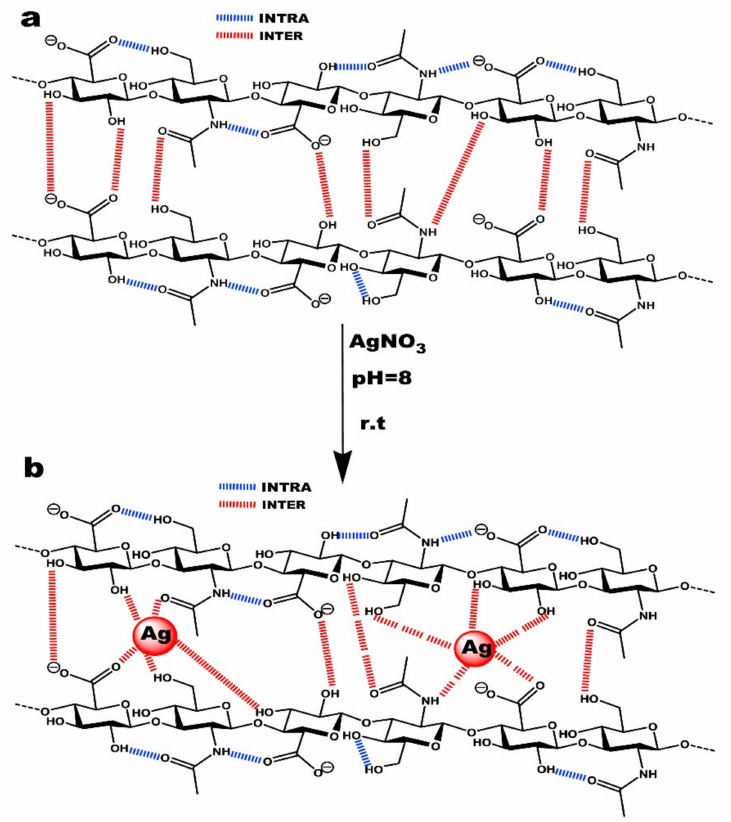
Figure 11. ( a ) Intra/intermolecular hydrogen bonds between hyaluronan chains and ( b ) the interac- tion mechanism between hyaluronan functional groups and silver nanoparticles. Reproduced with permission [155]. Copyright Elsevier,